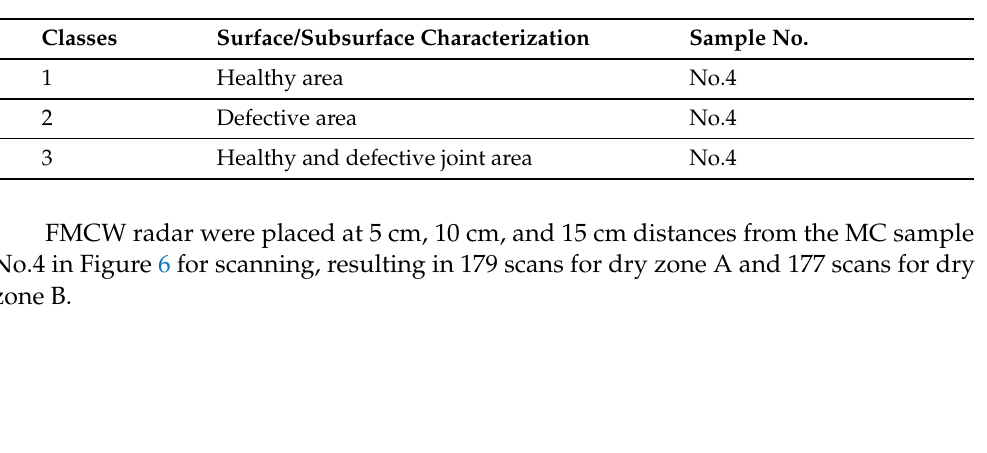
Table 7. Characterization classes for Interlaminar porosity